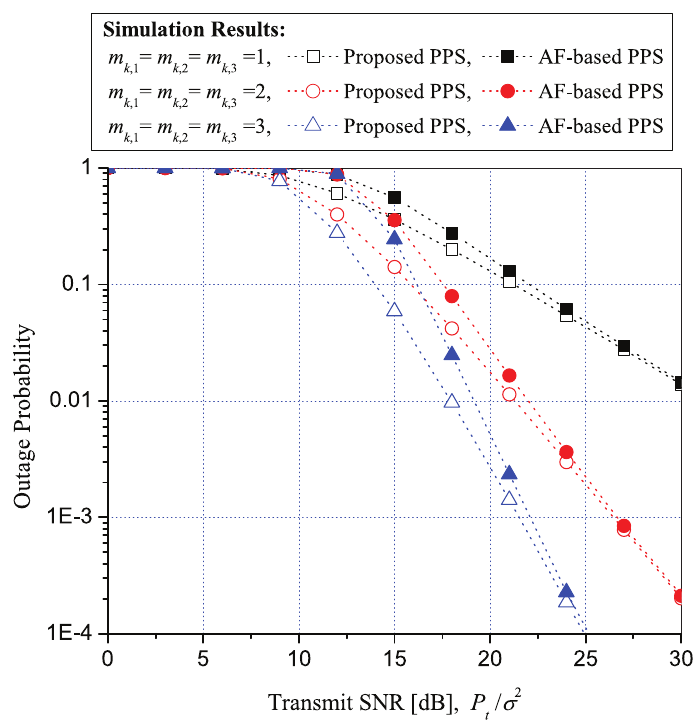
Figure 6. Outage probability of the proposed PPS with l k = 1 for all k and the conventional AF-based PPS, when m k , n ’s are equal, N k = 3 for all k , K = 3, and R t = 1